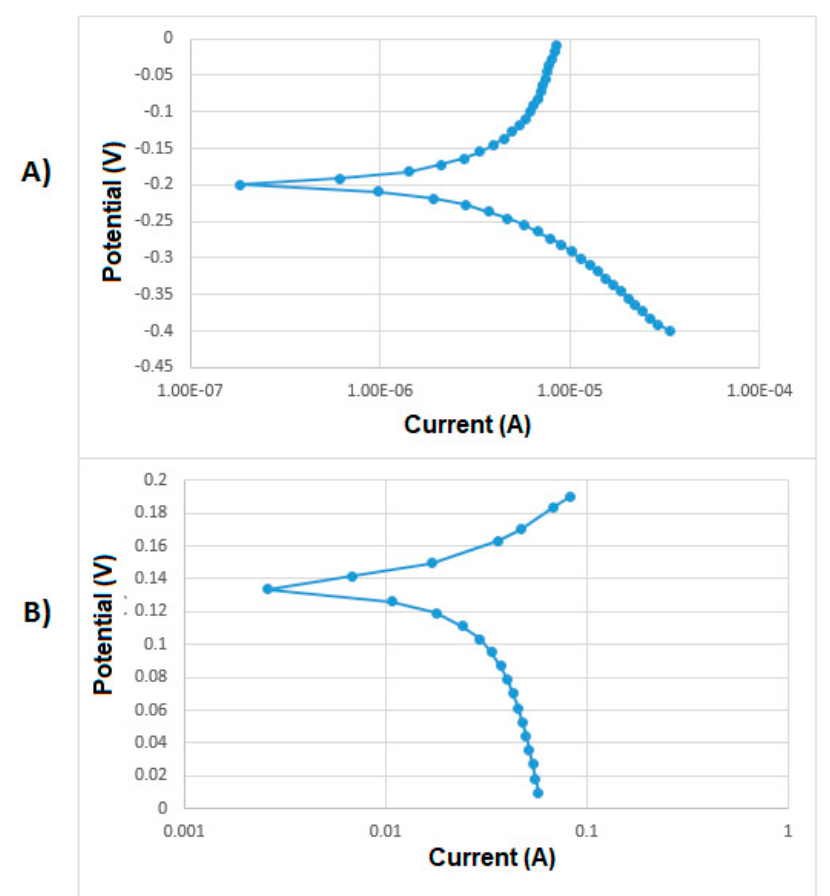
Figure 3. Tafel plot and analysis of ( A ) Monel (400) and ( B ) Monel coated with graphene quantum dots for 25 h. Potential is referred with SCE. Medium: 0.1 M NaCl.